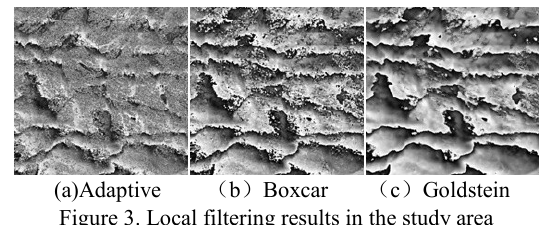
Figure 3. Local filtering results in the study area